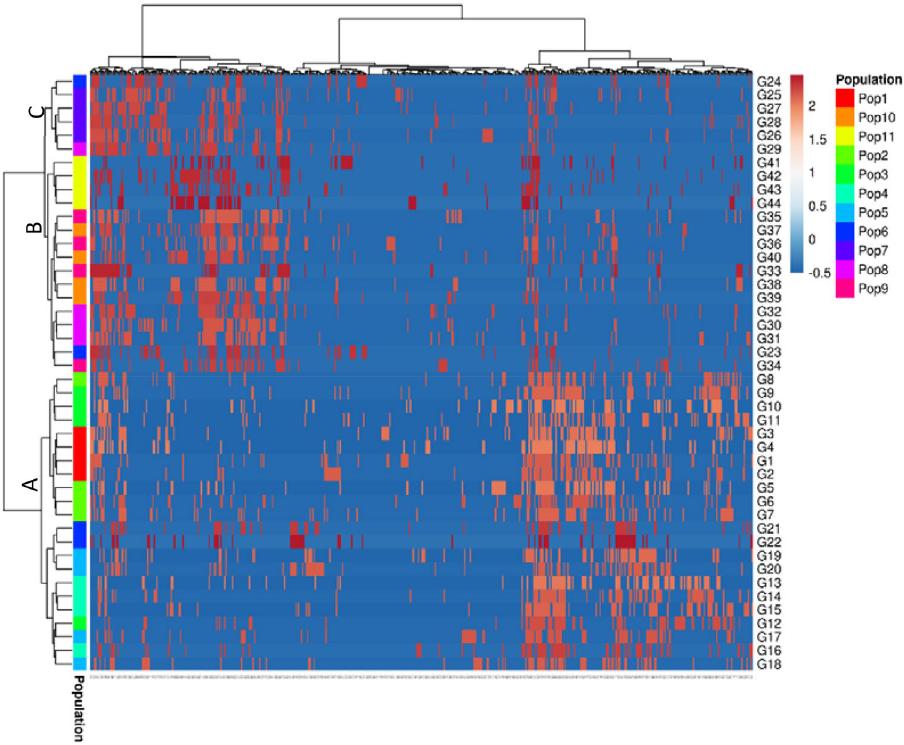
Figure 5. ISSR data-based heatmap of 44 V . subterranea accessions constructed by Euclidian distance with Ward (unsquared distances) linkage method using ClustVis Bio tools (https:// bio. tools/ clust vis). In this plot, the row allocated the 44 accessions under 11 population and the column assign for a total number of loci amplified by ISSR primer.